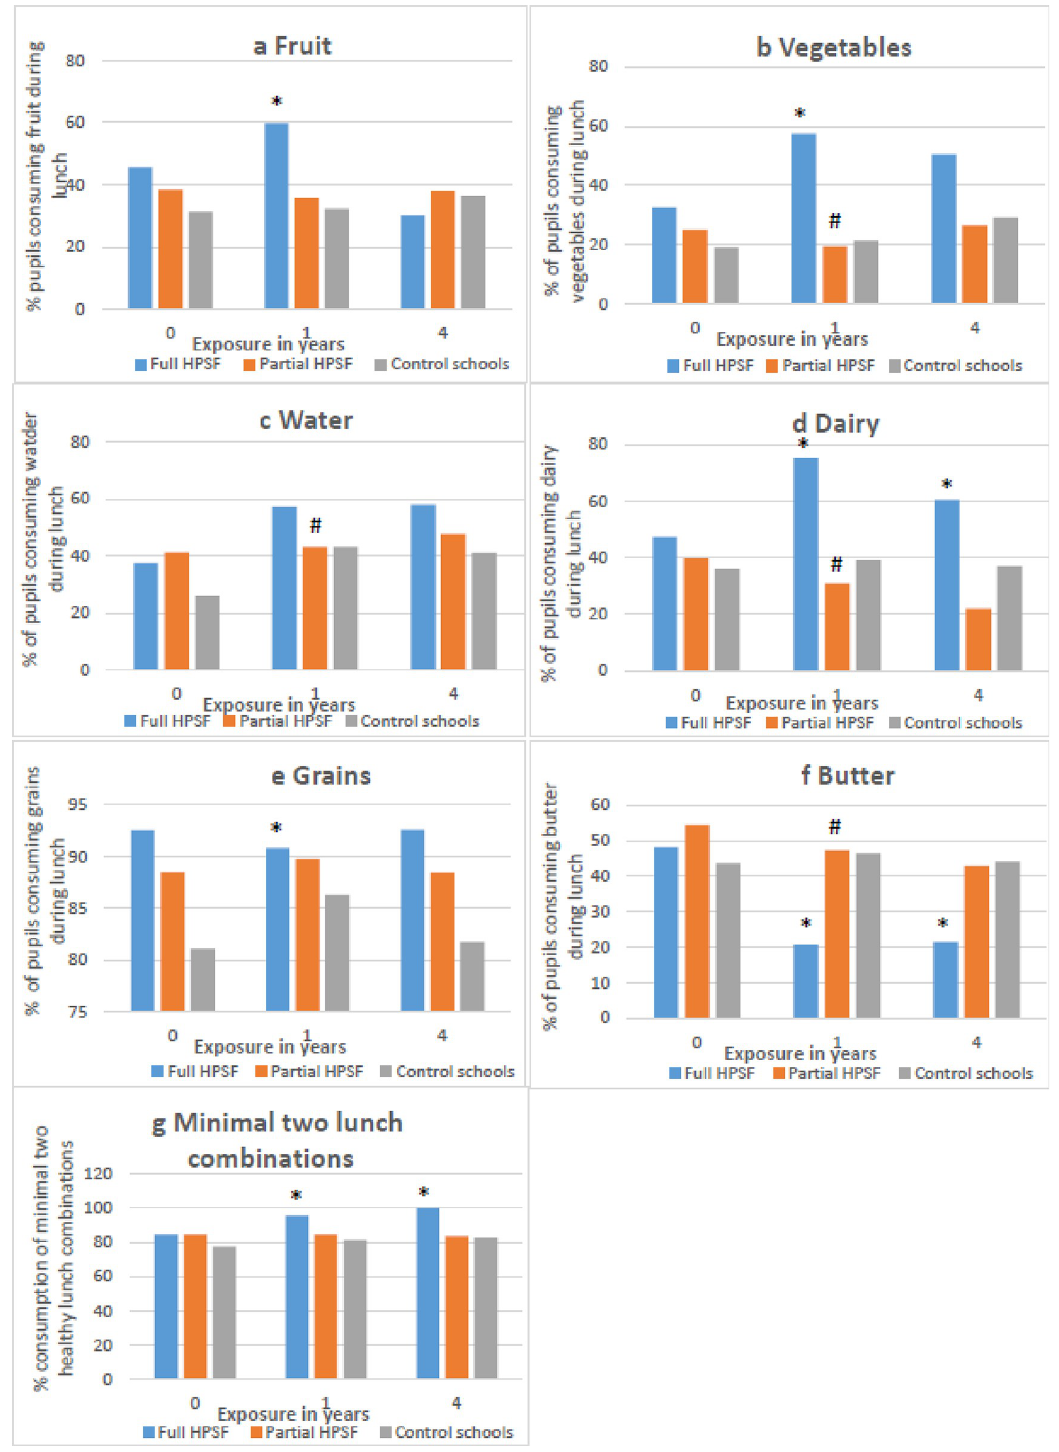
Fig 4. Observed percentage of lunch consumption: a) fruit, b) vegetables, c) water, d) dairy, e) grains, f) butter, h) minimal two healthy lunch combinations at baseline, one and four years of exposure. Abbreviations: BMI, body mass index; HPSF, Healthy Primary School of the Future. � = Significant difference between Full HPSF and control. # = Significant difference between Partial HPSF and control.